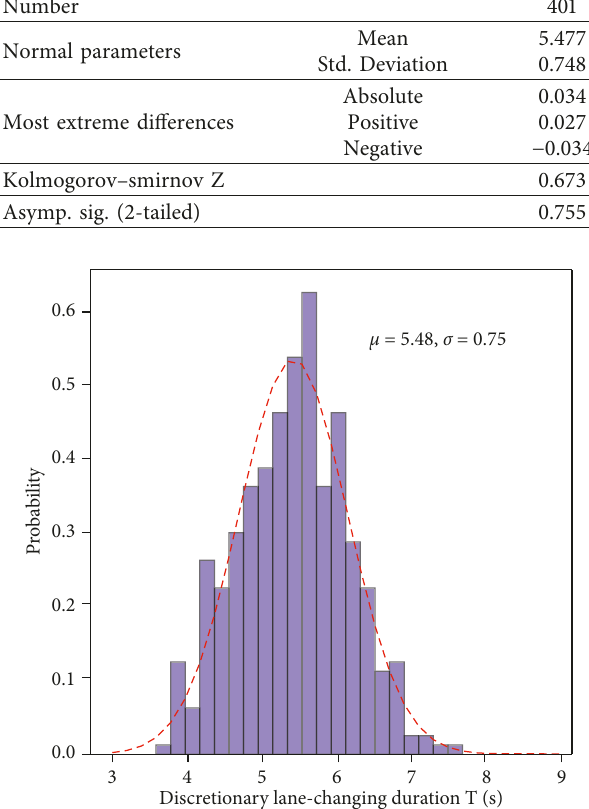
Table 2: One-sample Kolmogorov–Smirnov test. Number 401 Normal parameters